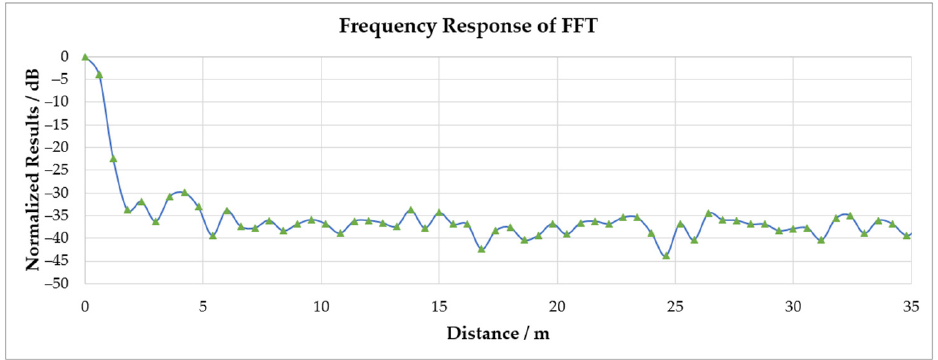
Figure 3. Frequency response of FFT.